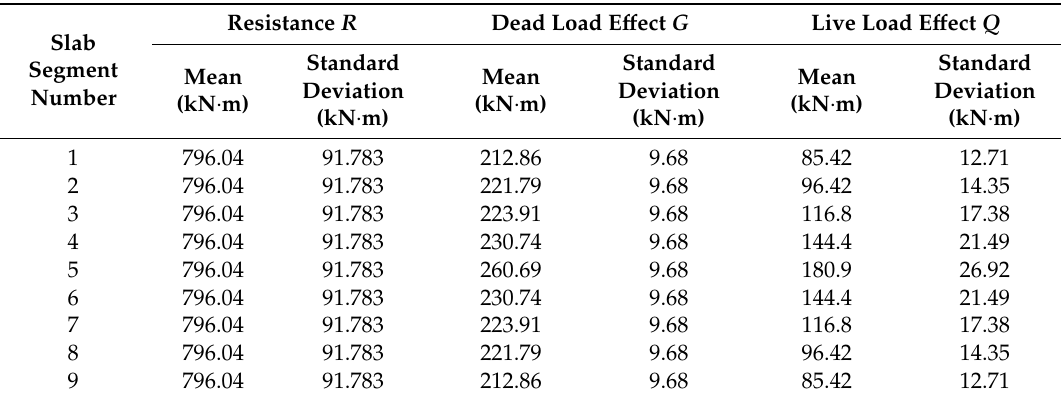
Table 3. Statistical parameters of the random variables [20].